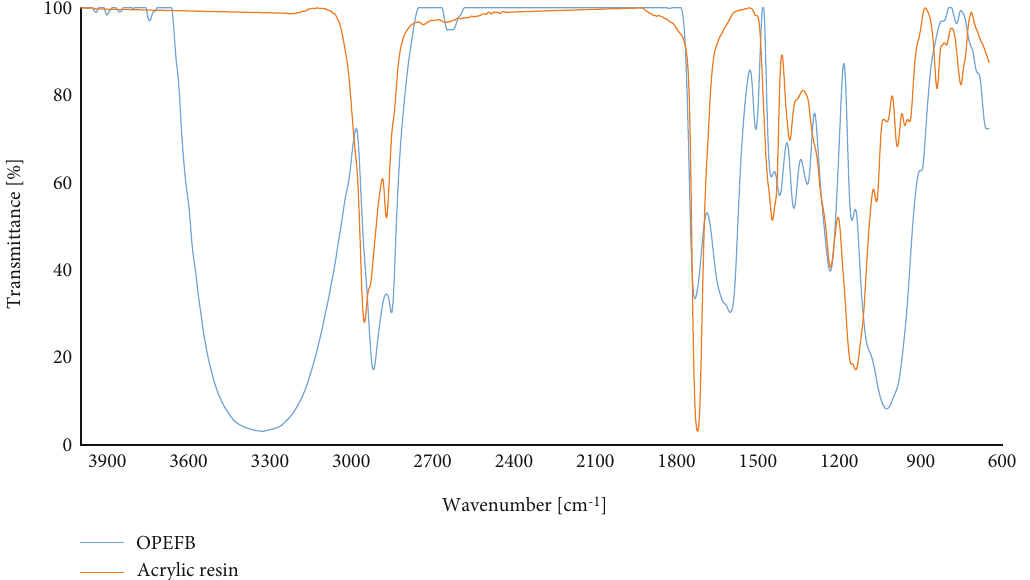
Figure 7: FTIR curves of raw